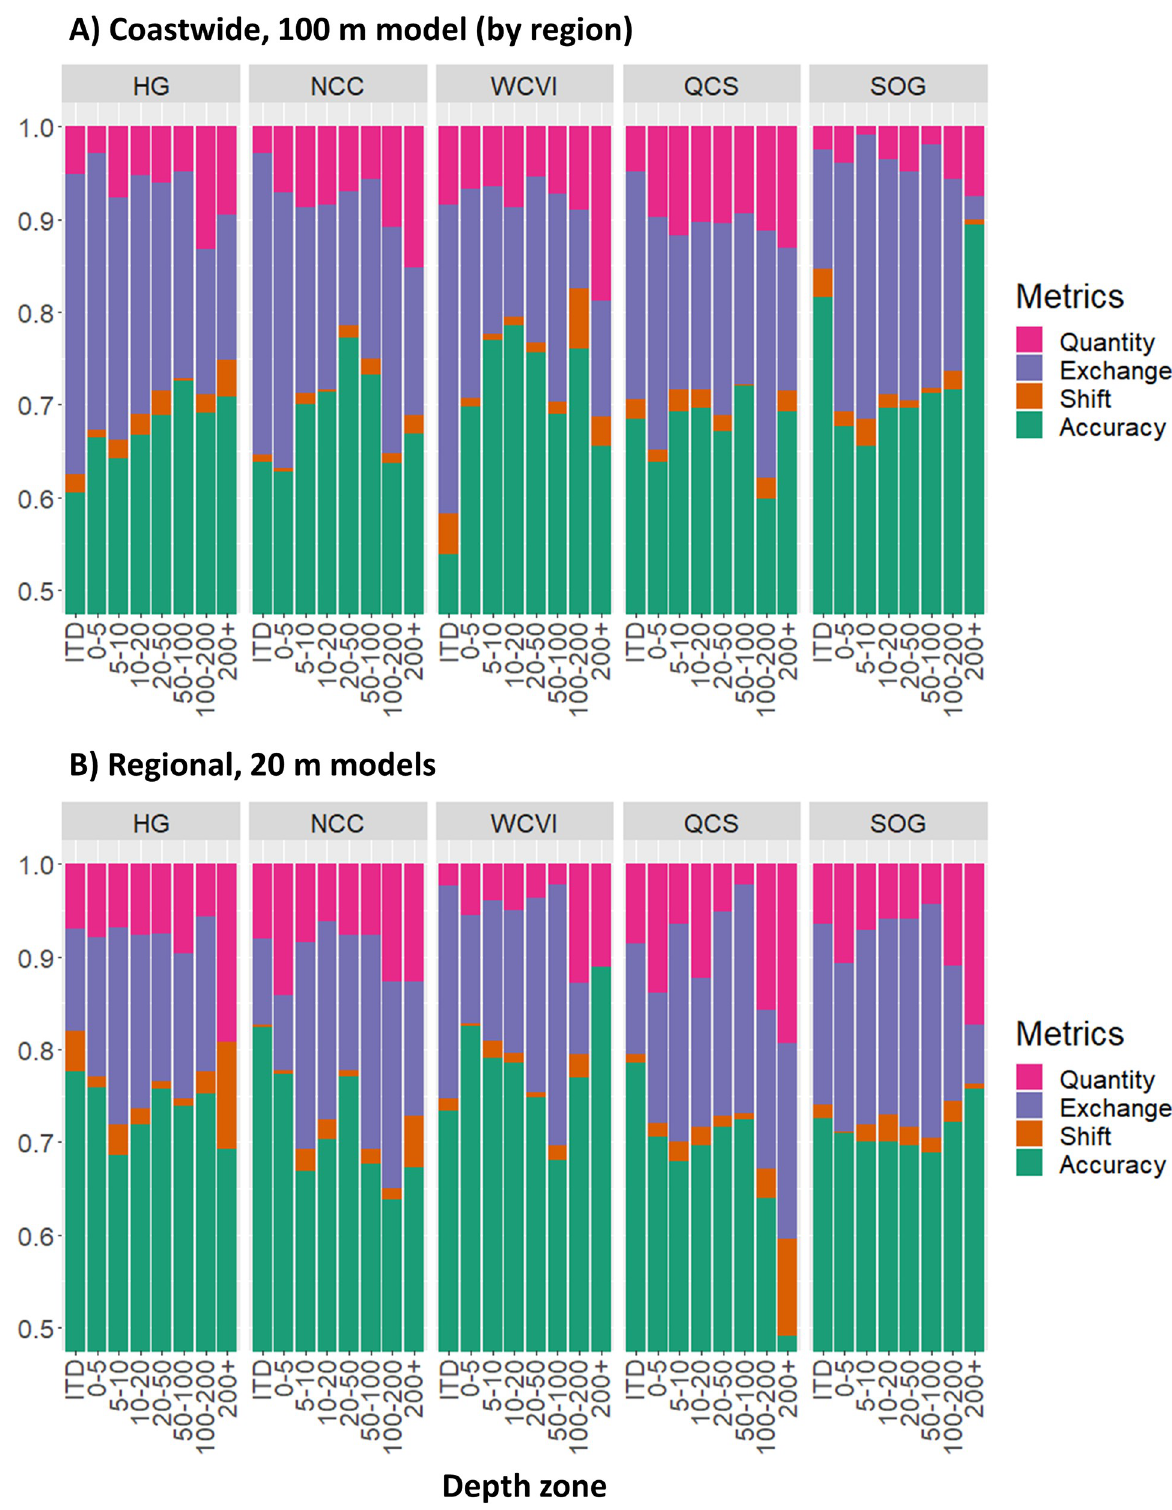
Fig 7. Error assessment of model fit by region, depth and resolution. Accuracy and error metrics for (A) the 100 m coastwide and (B) 20 m regional models shown across depth zones for each region, based on model fit to the build testing partition. Accuracy tends to increase with depth in the 100 m model and decrease with depth in the 20 m models, but the trends are